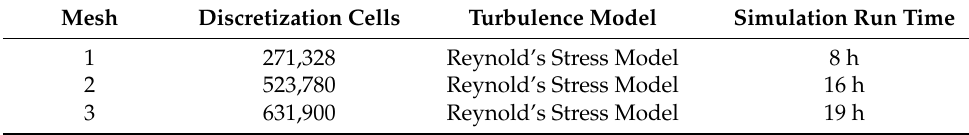
Table 1. Different types of discretization on the numerical model using proprietary software.